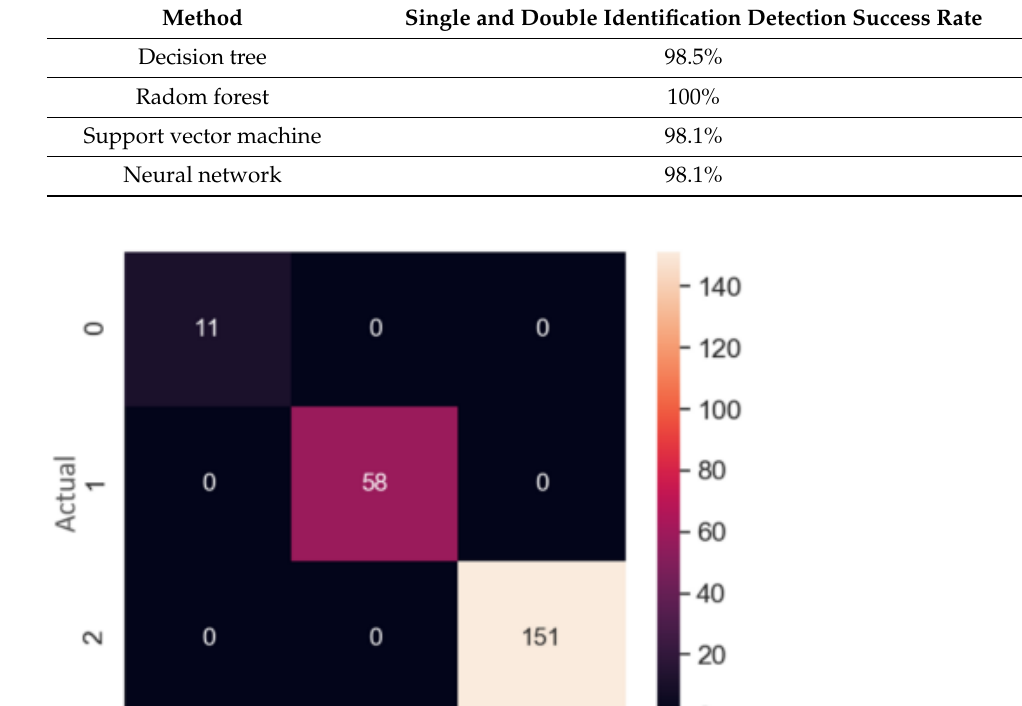
Table 11. Comparison of single and double identification and classification methods.